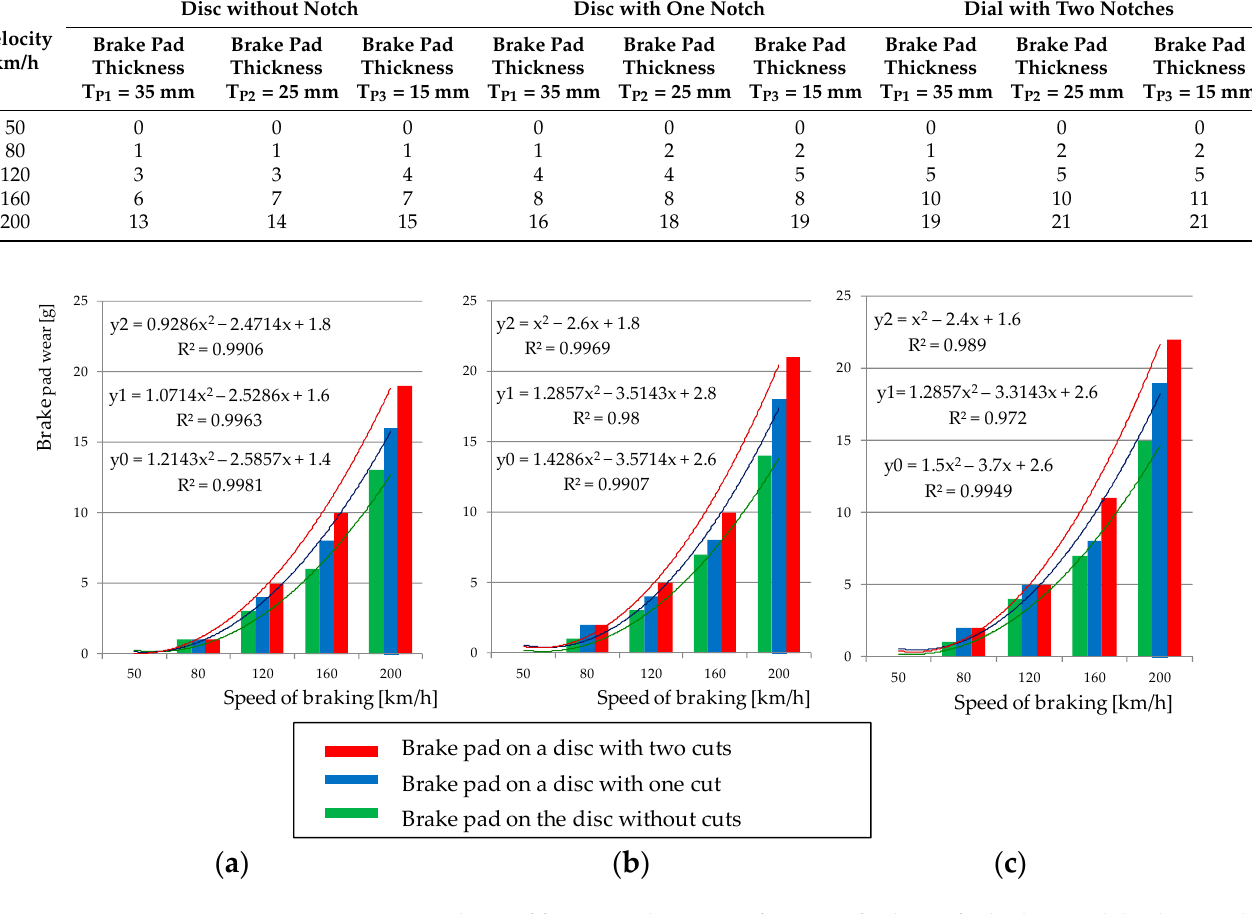
Figure 5. Dependence of friction pad wear as a function of velocity, for braking with load N = 36 kN,